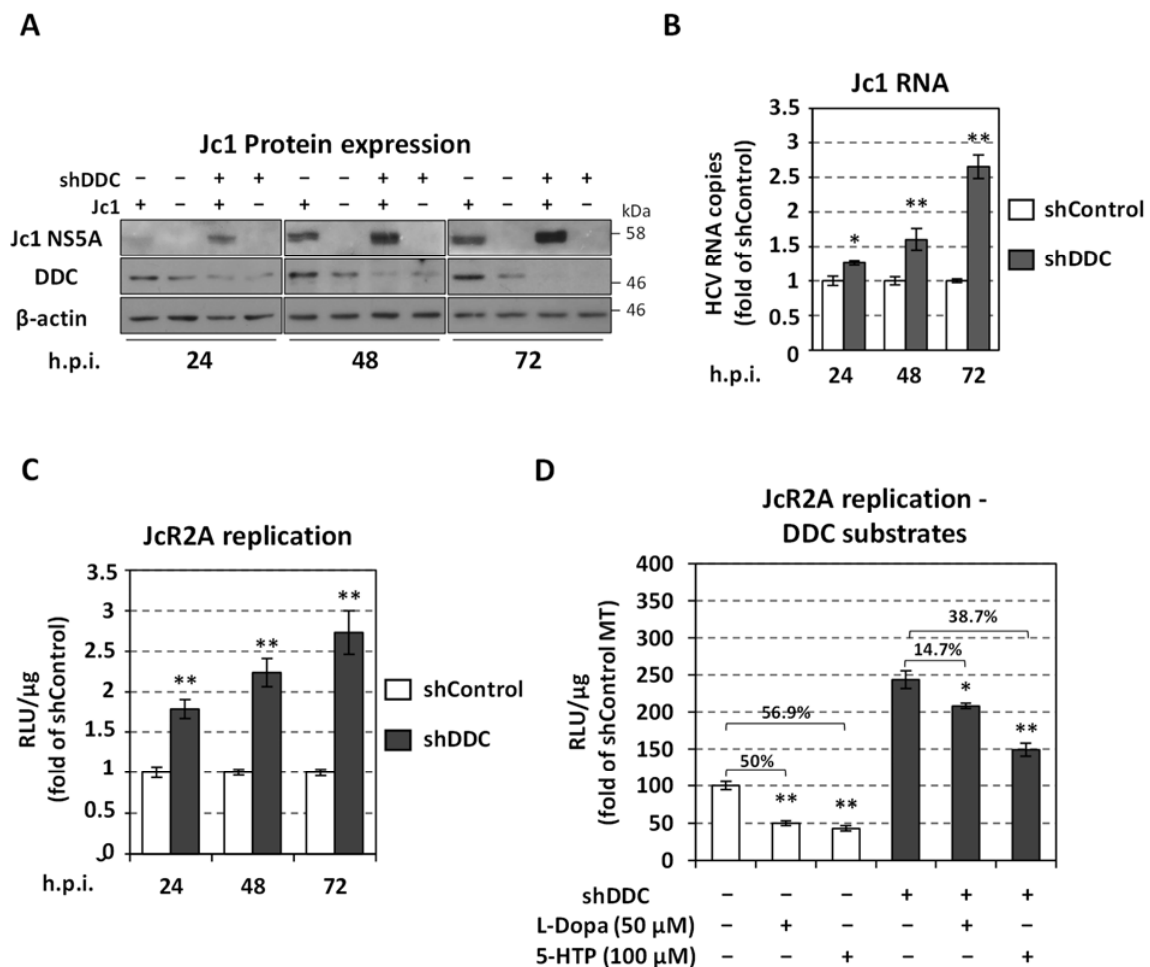
Figure 1. Effect of DDC silencing on HCV replication and on the antiviral activity of DDC substrates. Huh7.5 cells were electroporated with psi-LVRH1GP/sh-DDC (shDDC) plasmid or the control vector (shControl), inoculated 24 h p.t. with Jc1 (MOI = 1) ( A , B ) or the reporter virus JcR2A (MOI = 0.5) ( C , D ) for 4 h, and lysed at the indicated post-infection hours (h.p.i). ( A ) Western blot analysis of shDDC (+) and shControl ( − ) cells, using anti-DDC antibody, anti-NS5A antibody for the detection of Jc1 infection and β -actin as loading control. Mock-infected cells were used in parallel and are symbolized as Jc1 ( − ). A representative experiment of three independent triplicates is shown. ( B ) Jc1 positive-strand RNA levels were quantified by RT-qPCR and YWHAZ mRNA was used for normalization. Values from shControl cells were set to one at each time-point. ( C ) JcR2A replication-derived Renilla luciferase (R-Luc) activity was quantified by chemiluminescence-based assay and expressed as relative light units (RLU) per µ g of total protein amount. Values from shControl cells were set to one at each time-point. ( D ) JcR2A replication-derived R-Luc activity was quantified in shDDC (+) and shControl ( − ) cells, which were treated with 50 µ M L-Dopa or 100 µ M 5-HTP for 72 h starting from 4 h post-virus inoculation or were mock-treated (MT). Values from shControl MT cells were set to one. Percentages of viral-replication reduction after treatment, are shown above brackets. Bars represent mean values from three independent experiments in triplicate. Error bars indicate standard deviations. * p < 0.01, ** p < 0.001 vs.